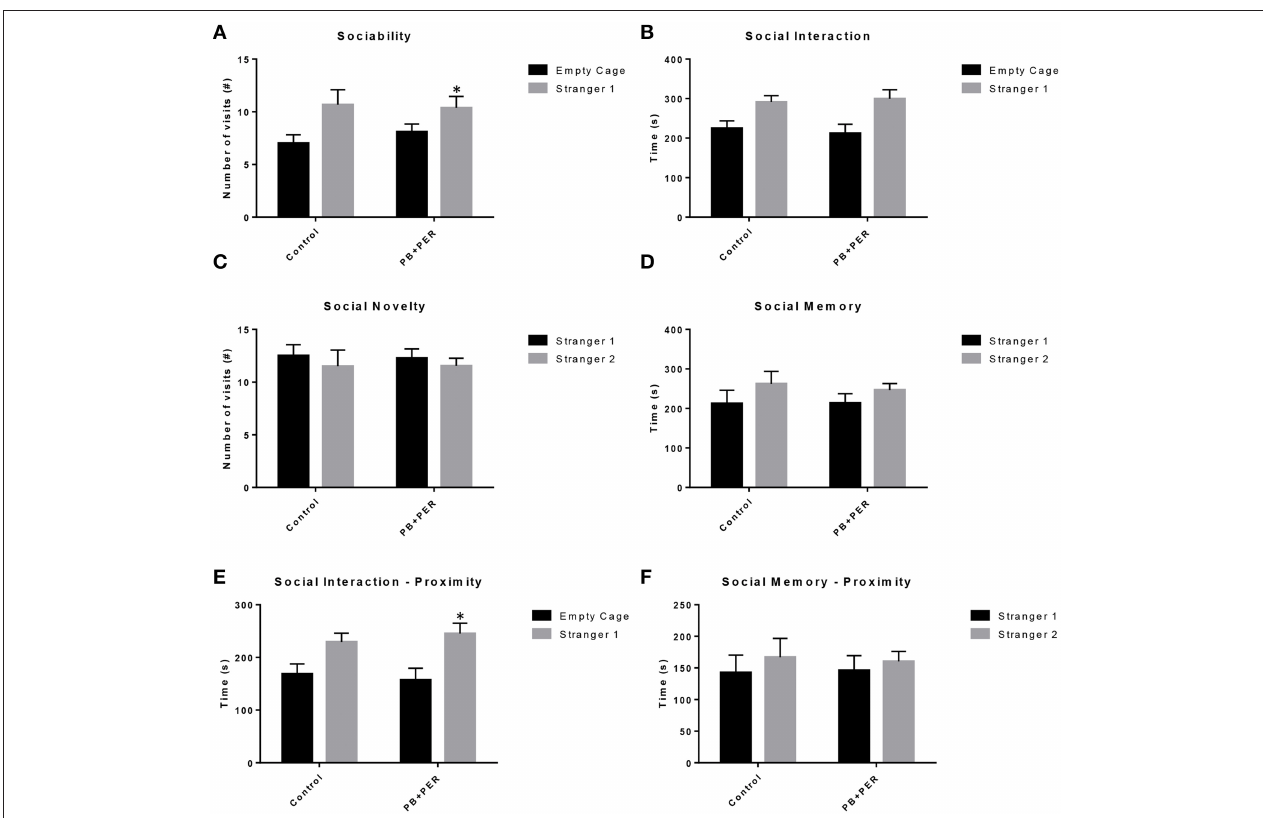
FIGURE 7 | Three Chamber testing revealed that PB + PER exposed mice exhibit normal sociability and social interaction behaviors, 22.5 months post exposure to GW agents. When examining (A) Sociability, the number of visits to either the empty cage or stranger 1, the control mice exhibited a slight trend toward an increased number of visits to the stranger 1 mouse as compared to the empty cage. In addition, PB + PER exposed mice demonstrated preference for the novel mouse (stranger 1) over the empty cage. When examining (B) Social Interaction, the time (s) the animals spent with either the empty cage or stranger 1, the control mice appeared to spend more time with stranger 1 as compared to the empty cage, although those differences did not reach statistical significance. Similarly, the PB + PER exposed mice continued to demonstrate a clear preference for the novel mouse (stranger 1) as compared to the empty cage. When examining (C) Social Novelty, the number of visits to either stranger 1 (familiar mouse) or stranger 2 (novel mouse), the control mice did not indicate a strong preference for one or the other, likewise, no differences in social novelty were evident when examining PB + PER exposed mice. In addition, when examining (D) Social Memory, as indicated by the time spent with either stranger 1 or stranger 2, the control mice did not demonstrate a strong preference to spend more time stranger 2 over stranger 1. Likewise, the PB + PER exposed mice did not show a strong preference for the novel mouse (stranger 2) over the familiar mouse (stranger 1). When examining (E) Social Interaction—Proximity (s), the control mice showed a trend indicating increased preference to spent more time with stranger 1 as compared to the empty cage, demonstrating normal healthy social behaviors. Likewise, the PB + PER mice showed a statistically significant preference to spent more time with stranger 1 as compared to the empty cage. When examining (F) Social Memory—Proximity (s), both the control and the PB + PER exposed mice did not show a strong preference for the novel mouse (stranger 2) over the familiar mouse (stranger